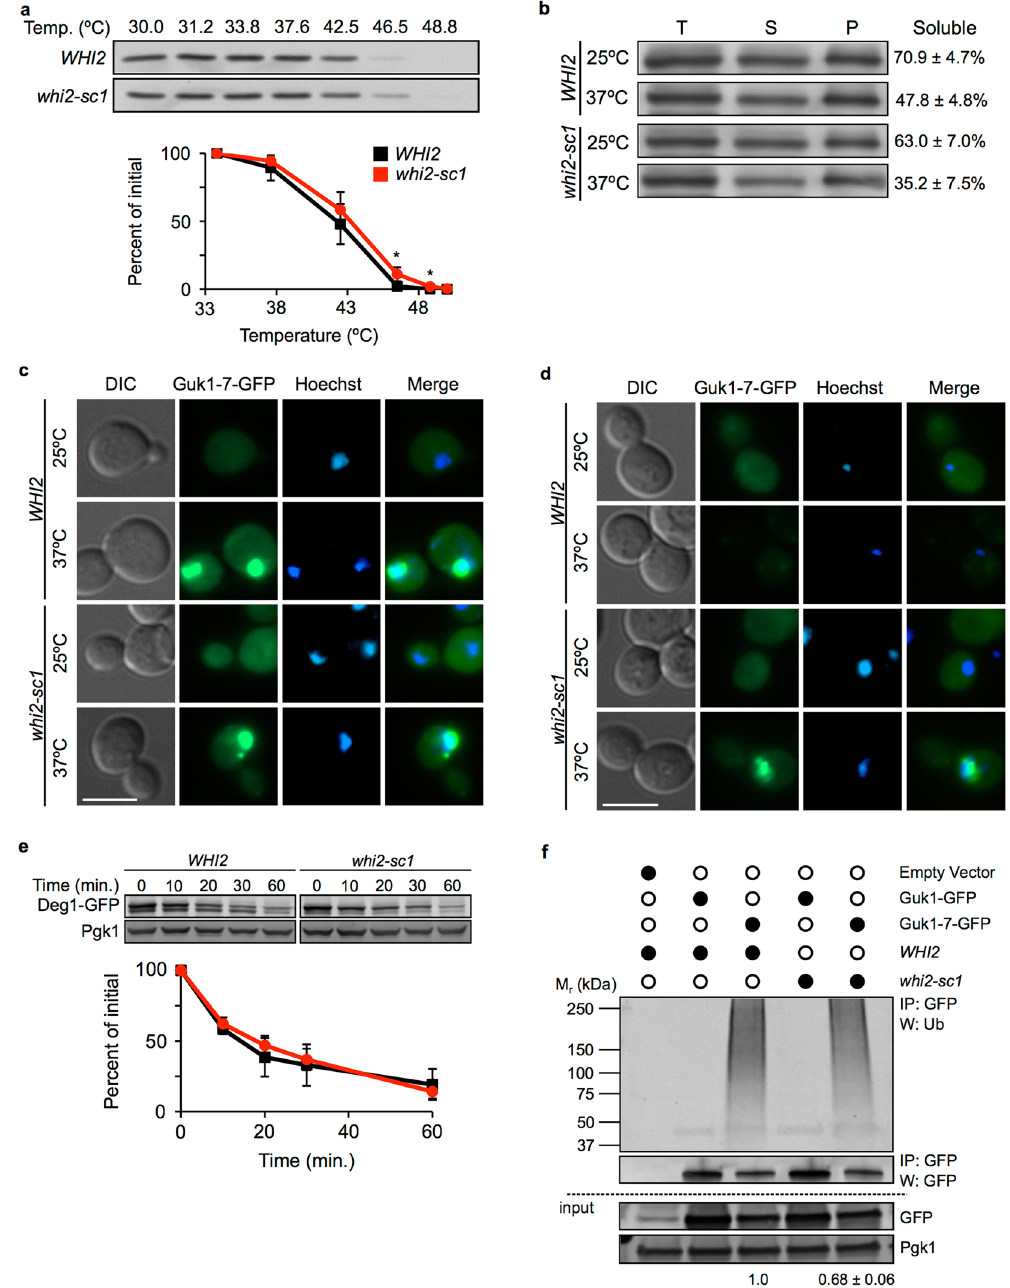
Figure 4. whi2 ∆ promotes Guk1-7-GFP stability through reduced ubiquitination. ( a ) Cellular thermal shift assay of Guk1-7 fused to a six histidine tag in lysates of WHI2 and whi2-sc1 cells grown at 25°C. One representative anti-His western blot is shown. The graph represents the means and standard deviations of Guk1-7 levels from three independent experiments. P values were calculated with a two-tailed unpaired Student’s t -test ( * denotes p < 0.05). ( b ) WHI2 and whi2-sc1 cells expressing Guk1-7-GFP were grown at 25°C or shifted to 37°C for 20 min. Total cell lysate (T), soluble (S), and pellet fractions (P) were immunoblotted with an anti-GFP antibody. One representative blot is shown and the ratio of soluble fraction to total cell lysate is noted and represents the mean and standard deviation of three independent experiments. Although, slightly lower levels were recovered in the soluble fractions of whi2-sc1 cells, the differences with wild type cells were not significant. ( c ) WHI2 or whi2-sc1 cells expressing Guk1-7-GFP were grown at 25°C and then incubated at 25°C or 37°C for 20 minutes with CHX before fixation and imaging. The scale bar represents 5 µ m. ( d ) As in ( c ) except cells were incubated in the presence of CHX for 2 hours at 25°C or 37°C. ( e ) Turnover of a constitutive substrate of the UPS. WHI2 and whi2-sc1 cells expressing Deg1-GFP under the Cup1 promoter were incubated with CHX at 30°C and samples were collected at the indicated time points. Membranes were immunoblotted with an anti-GFP antibody and an anti-Pgk1 antibody as a loading control. The graph represents the mean and standard deviation of three independent experiments. ( f ) Guk1-GFP or Guk1-7-GFP were